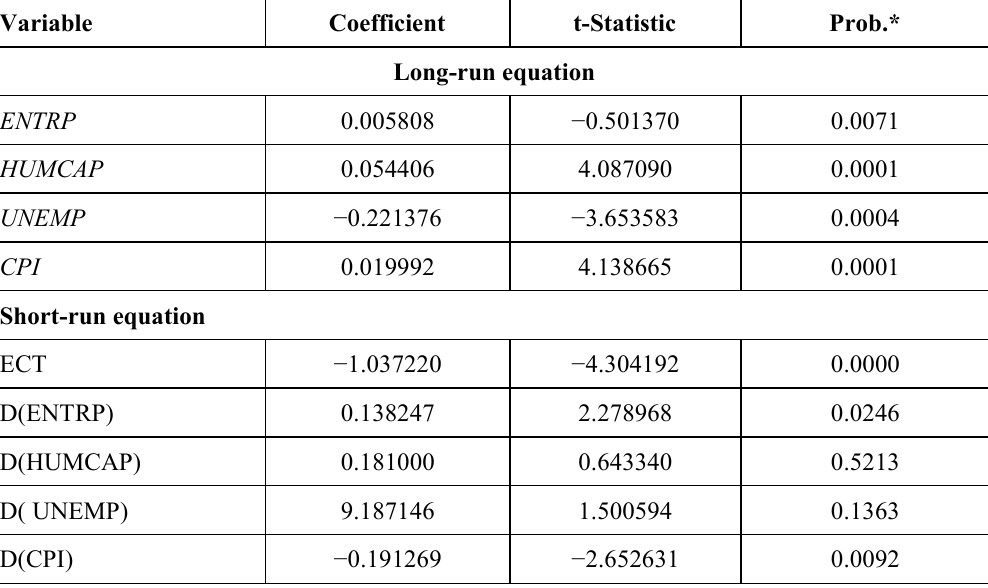
Table 4. Inequality and Entrepreneurship PARDL/PMG